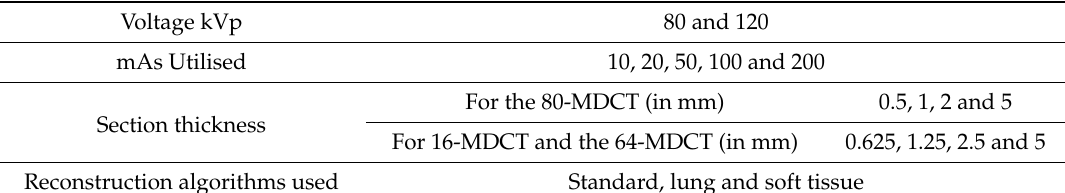
Table 2. The Protocol parameters utilised for image